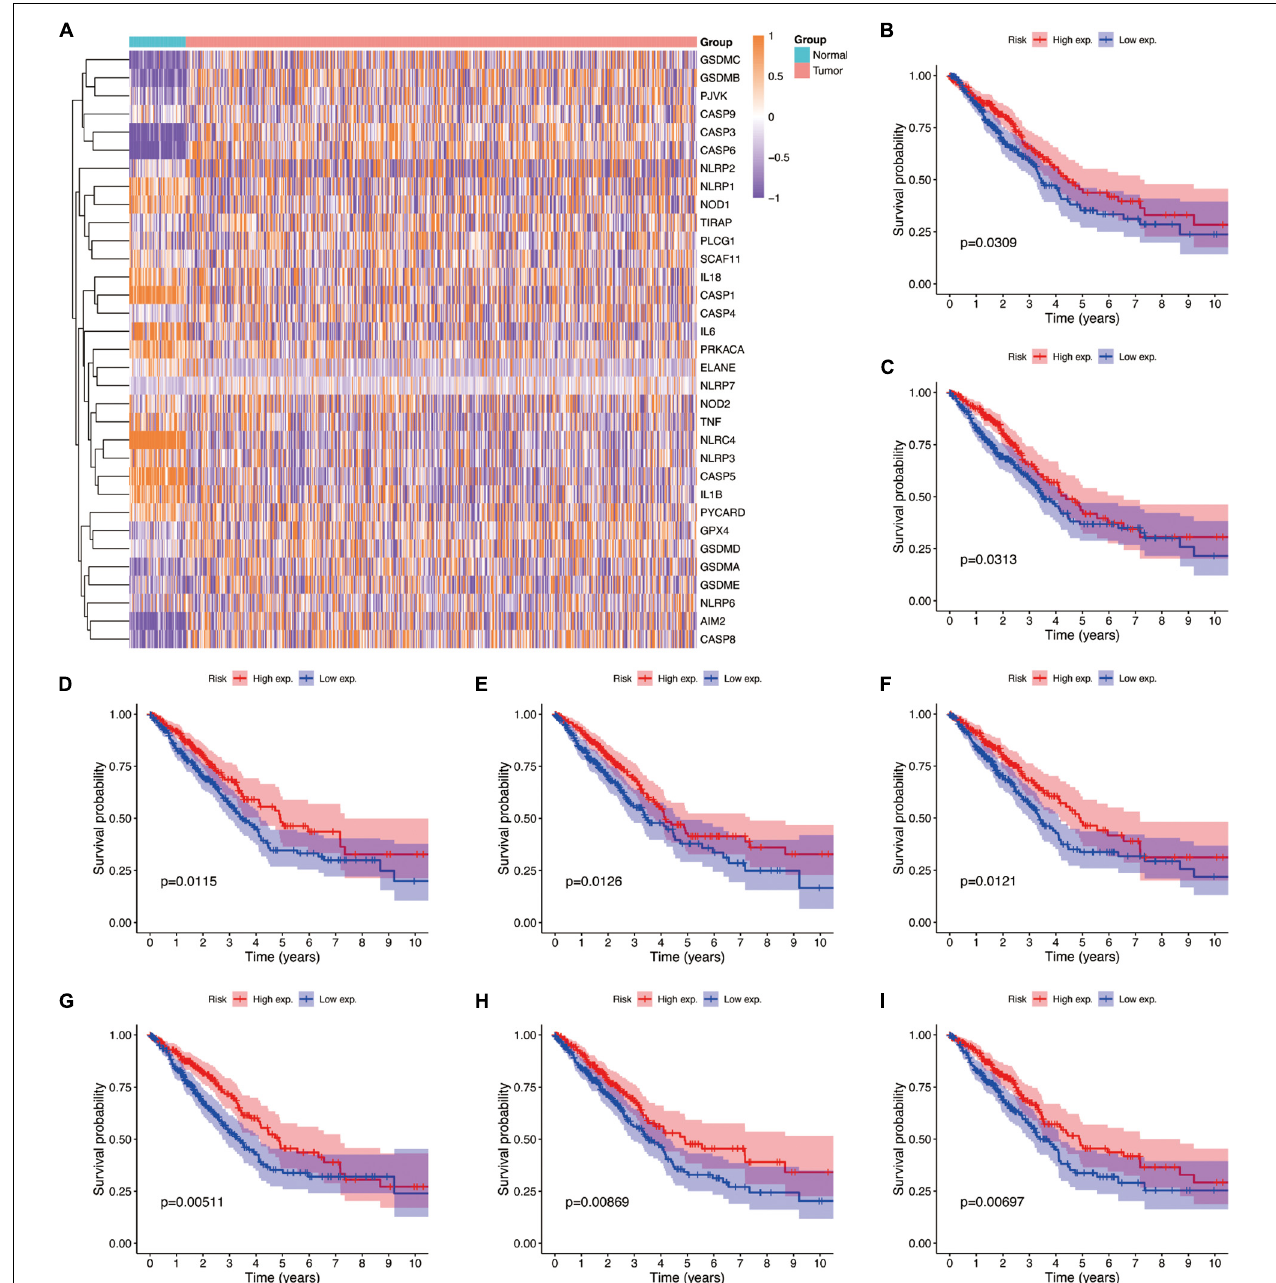
FIGURE 4 | The expressions of the 33 pyroptosis-related genes and prognostic value for LUAD. (A) Heatmap (blue, low expression level; orange, high expression level) of the pyroptosis-related genes between the normal and the tumor tissues. (B–I) Kaplan–Meier analysis of GPX4, NLRC4, NLRP1, NLRP2, NLRP3, NOD1, PLCG1 , and PRKACA in TCGA cohort. Adjusted P -value < 0.05 is considered significant (High exp., high expression level; Low exp., low expression